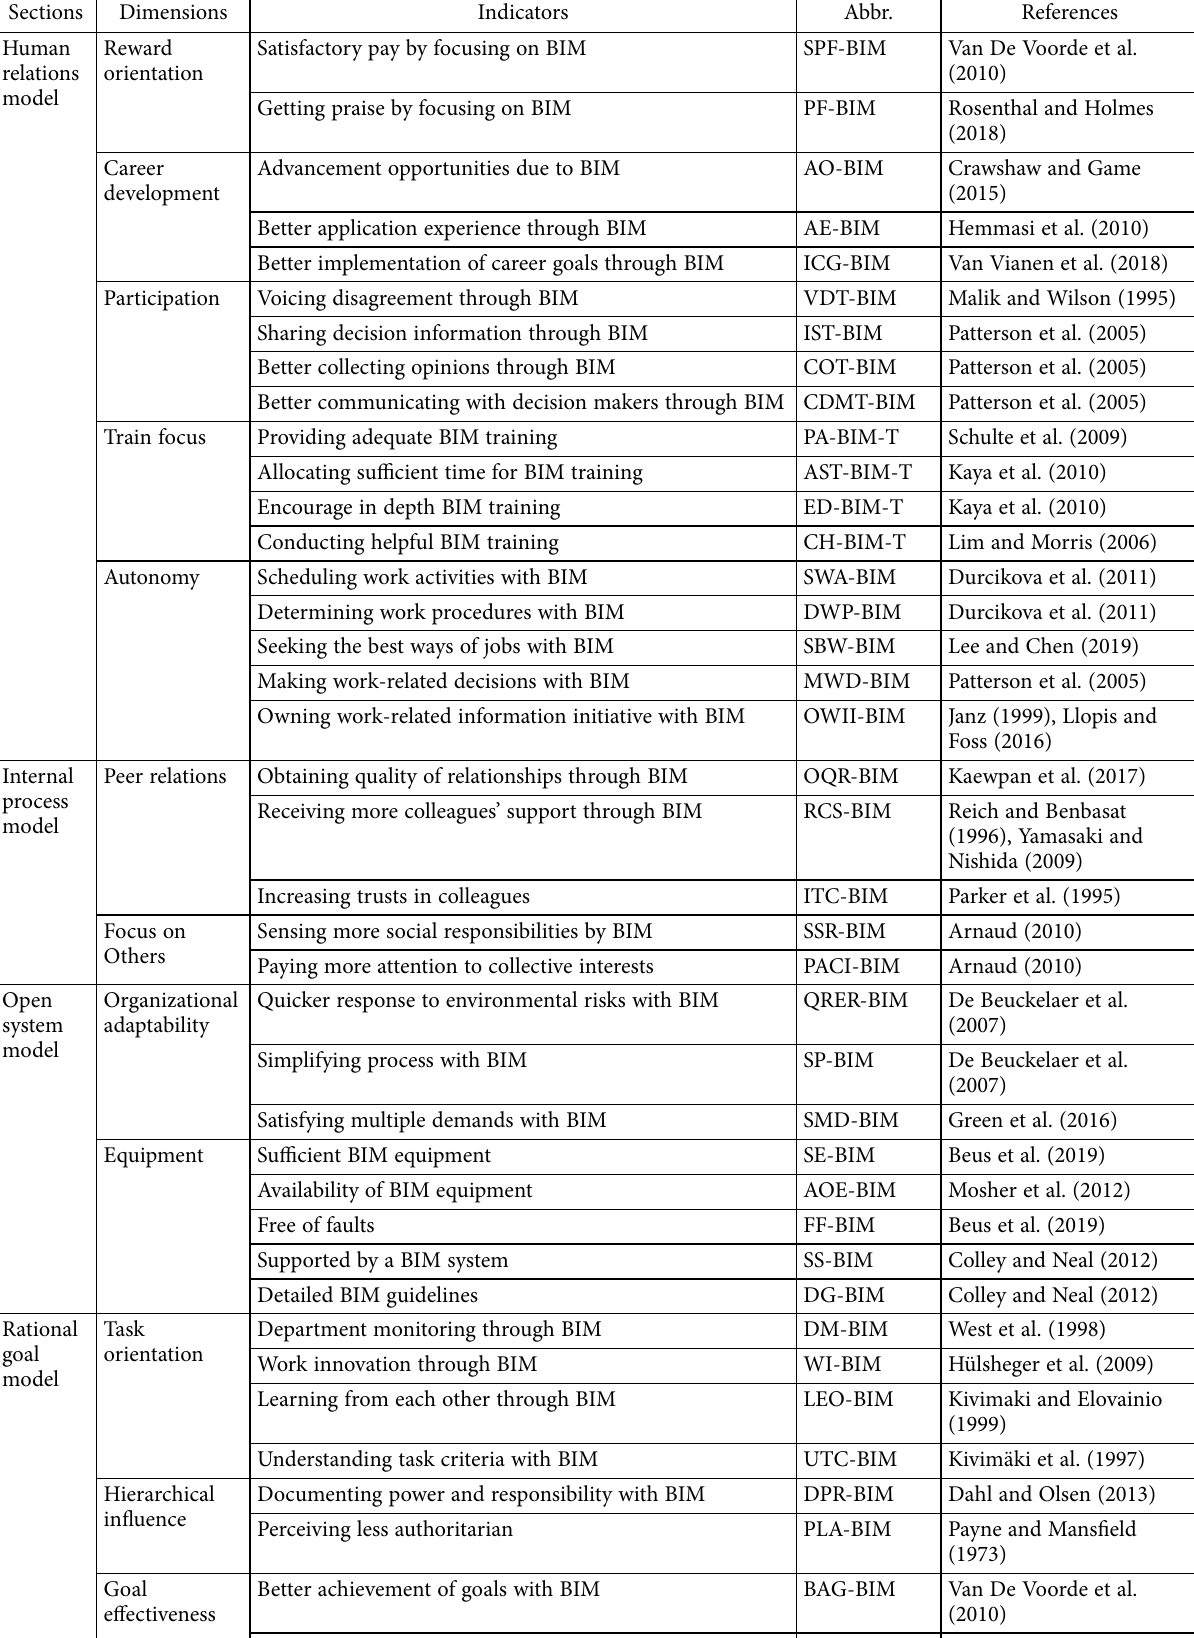
Table 2. Indicators of value-added oriented BIM